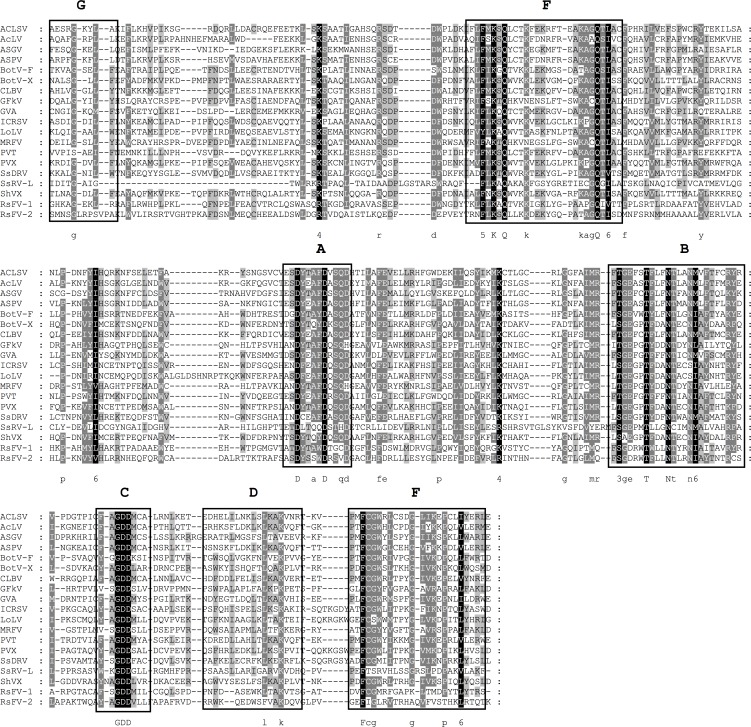
Identification of the conserved motifs A to G in the RdRp domain of the type species of all genera within the order Tymovirales.The RdRp domains of Rhizoctonia solani flexivirus 1 (RsFV-1) (KX349064), Rhizoctonia solani flexivirus 2 (RSFV-2) (KX349069) and the type species of all genera within the Tymovirales [8] were aligned using MEGA 6.06 and the sequence alignment algorithm MUSCLE [44]. Conserved motifs A to G were marked according to Bruenn 2003, Černý et al. 2014, Koonin et al. 1993, Boehr et al. 2014 and Xu et al. 2003 [30, 34, 42–44]. ACLSV, Apple chlorotic leaf spot virus (ABY71563.1); AcLV, Aconitum latent virus (NP_116487.1); ASGV, Apple stem grooving virus (BAA98054.1); ASPV, Apple stem pitting virus (AEP02955.1); BotV-F, Botrytis virus F (NP_068549.1); BotV-X, Botrytis virus X (NP_932306.1); CLBV, Citrus leaf blotch virus (NP_624333.1); GFkV, Grapevine fleck virus (NP_542612.1); GVA, Grapevine virus A (AAO17778.1); ICRSV, Indian citrus ringspot virus (NP_203553.1); LoLV, Lolium latent virus (YP_001718499.1); MRFV, Maize rayado fino virus (NP_115454.1); PVT, Potato virus T (BAM16482.1); PVX, Potato virus X (AAF89747.1); SsDRV, Sclerotinia sclerotiorum debilitation-associated RNA virus (YP_325662.1); ShVX, Shallot virus X (NP_620648.1). Shading indicates level of conservation and the consensus sequence is displayed.